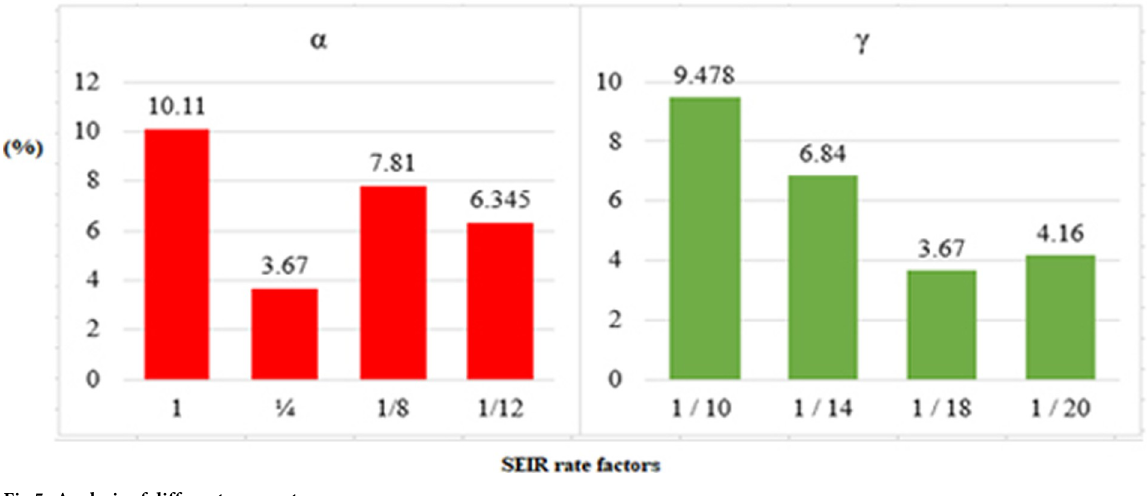
Fig 5. Analysis of different parameters.